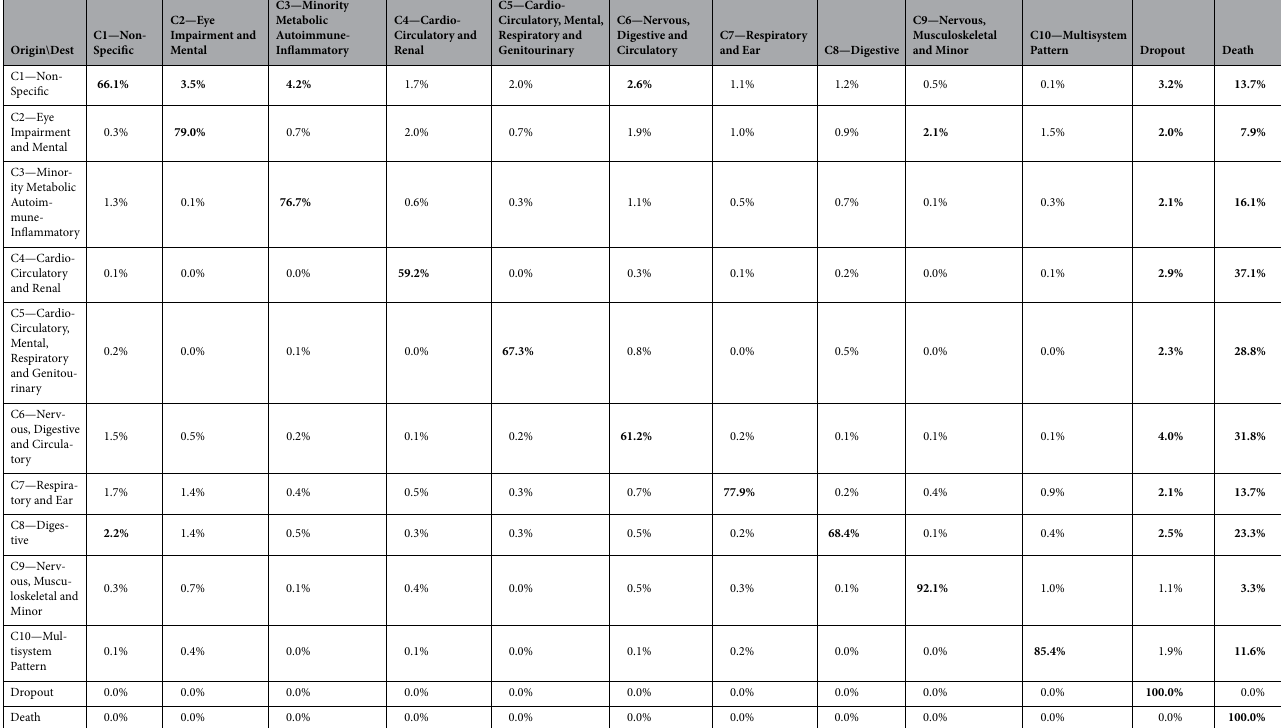
Table 1. Transition probabilities for Viterbi decoding from start to end of study. Bold show probabilities higher than 2%.